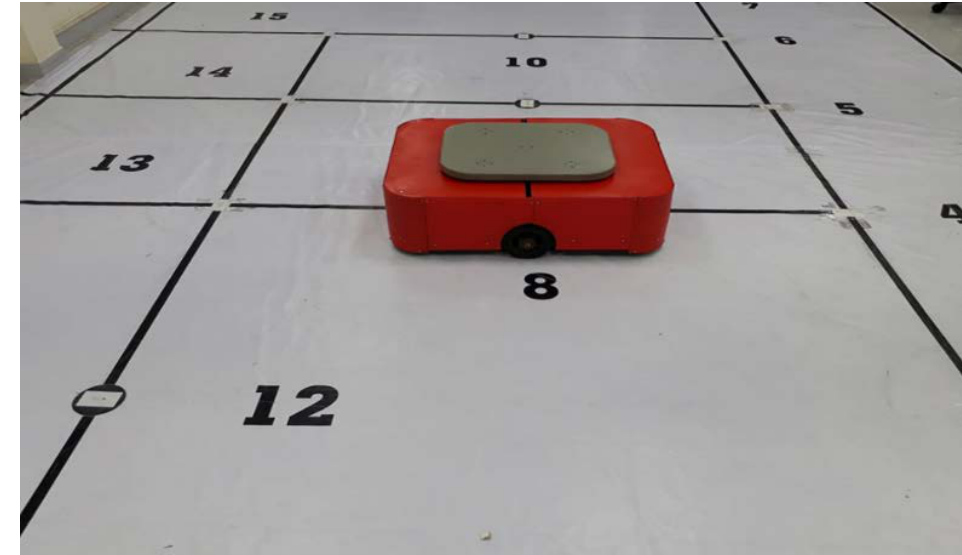
Figure 2. Experimental platform of AGR.